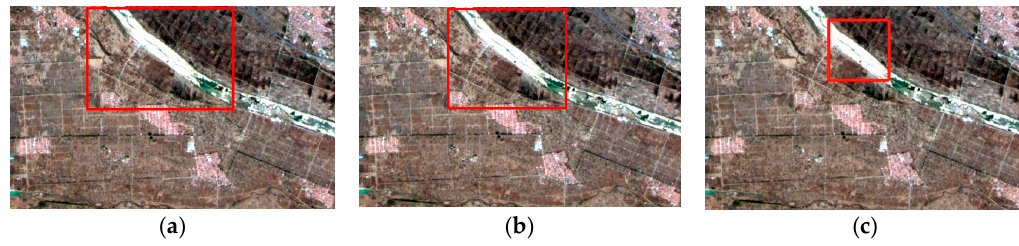
Figure 11. False detection result in an image with no airport in it. ( a ) Faster R-CNN; ( b ) proposed method; ( c ) LSD + AlexNet. [Image courtesy of Google Earth].